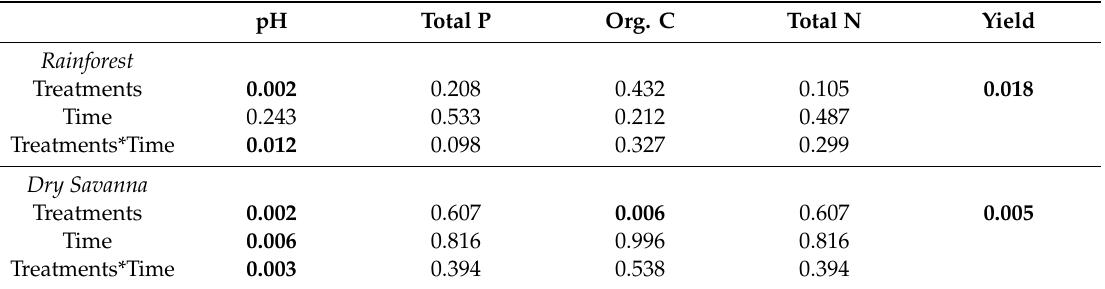
Table 2. P -value results of an ANOVA on organic carbon, pH, total nitrogen and phosphorus and yield (significant di ff erences, i.e., p ≤ 0.05 are in